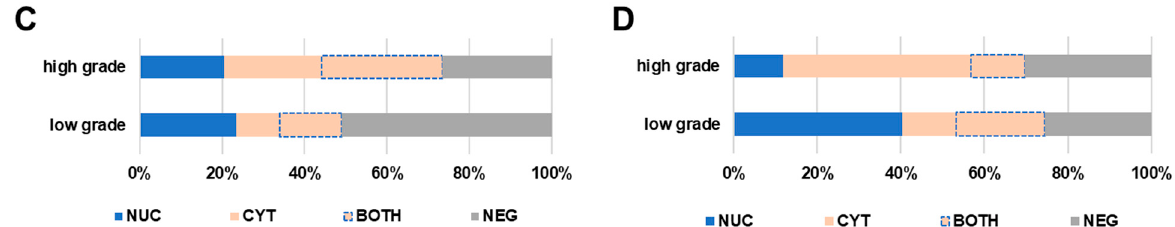
Figure 2. TR beta/TR beta-1 subcellular localization. The nuclear and cytoplasmic signal of TR beta and TR beta-1 were assessed independently by using a four-sided score. Relative fractions of each subcellular localization recognizing exclusive nuclear stain (NUC, blue), exclusive cytoplasmic stain (CYT, light orange), and the co-occurrence of nuclear and cytoplasmic signal (BOTH, light-orange with dotted blue line), as well as the complete loss of both (NEG, grey), were calculated. This four-sided score was correlated with histologic subtype and grade. The subcellular distribution of TR beta ( A , C ) and TR beta-1 ( B , D ) significantly changed with ovarian cancer histologic subtypes and grade ( C , D ).